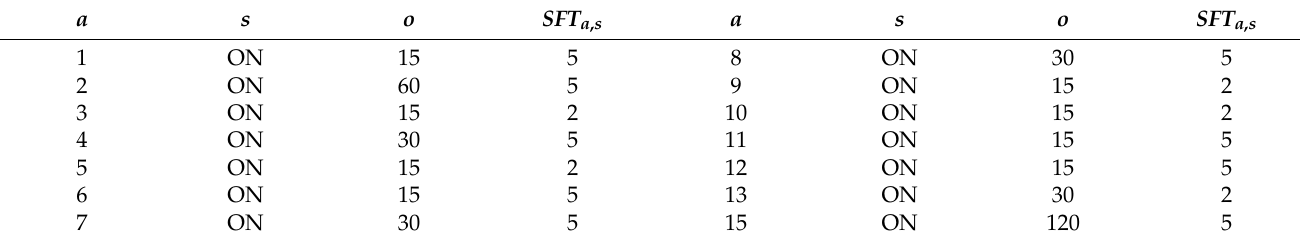
Table 2. Values of o and SFT a , s for events of turning the appliances on.